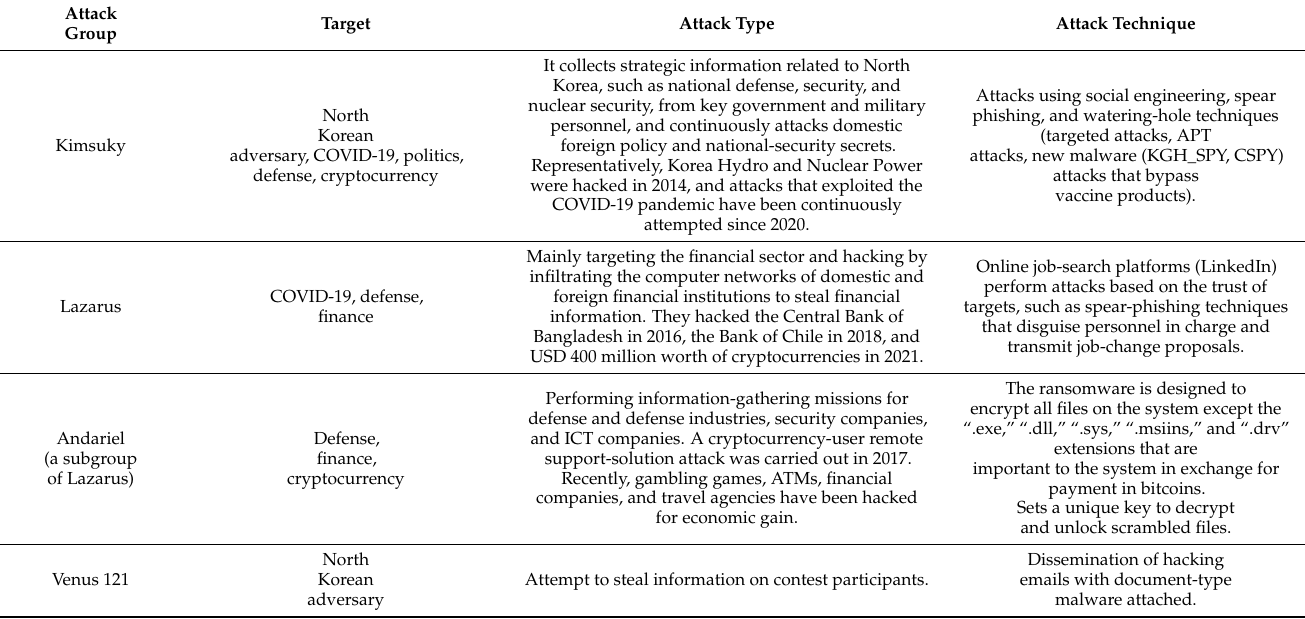
Table 2, the main attack targets, types, and techniques for each North Korean cyber-attack group were analyzed. Table 2. Major targets and techniques for each cyber-attack group in North